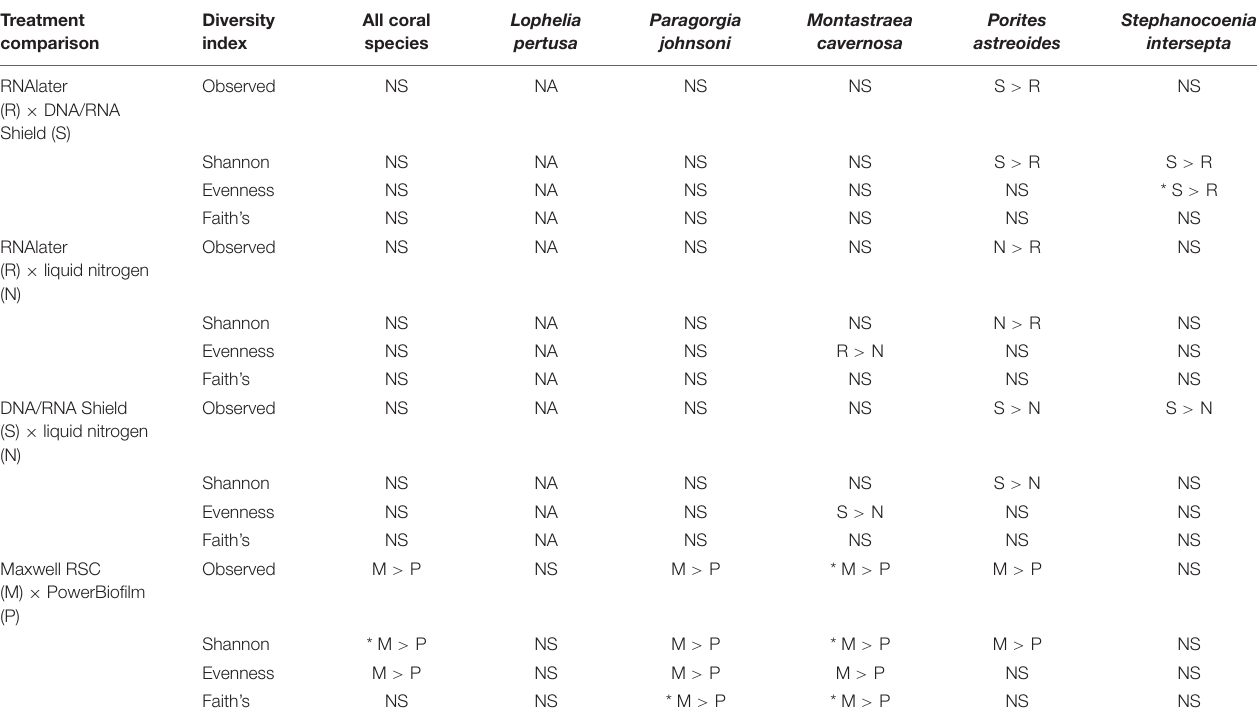
TABLE 3 | Pairwise results for each permutational multivariate analysis of variance (PERMANOVA) for all alpha diversity metrics, coral species, extraction methods (PowerBiofilm, Maxwell RSC), and preservatives (RNAlater, DNA/RNA Shield, liquid nitrogen). Treatment comparison